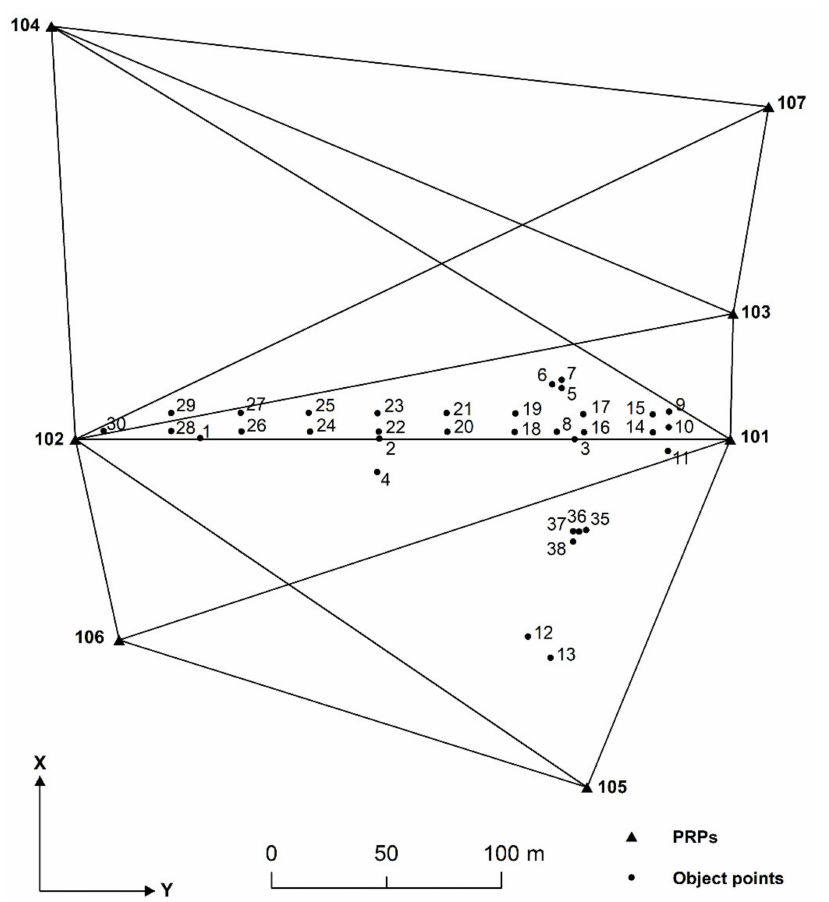
Figure 2. Geodetic network of Šelevrenac